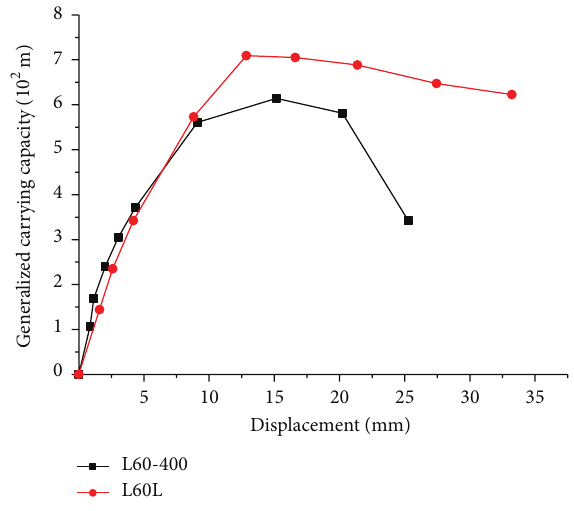
Figure 6: Contrast between L60L and